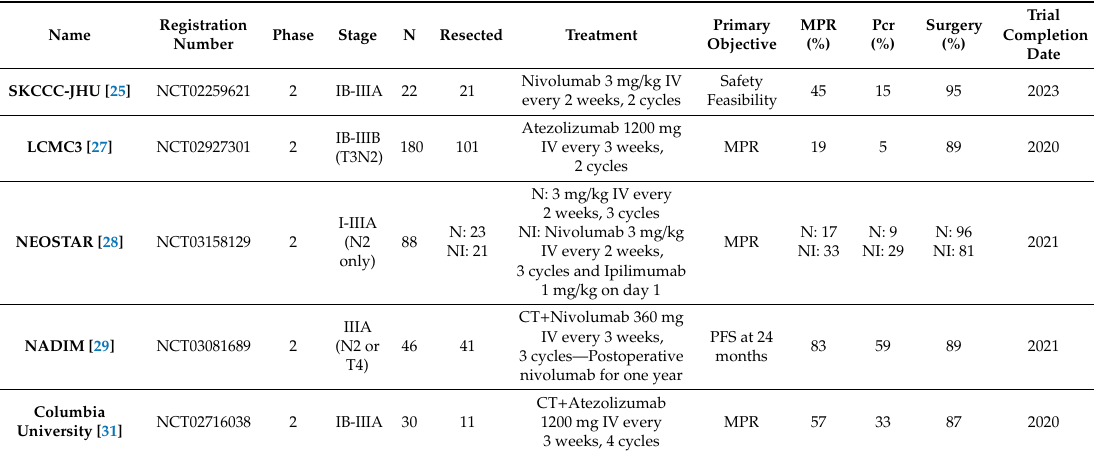
Table 3. Clinical trials of neoadjuvant ICI with or without chemotherapy.